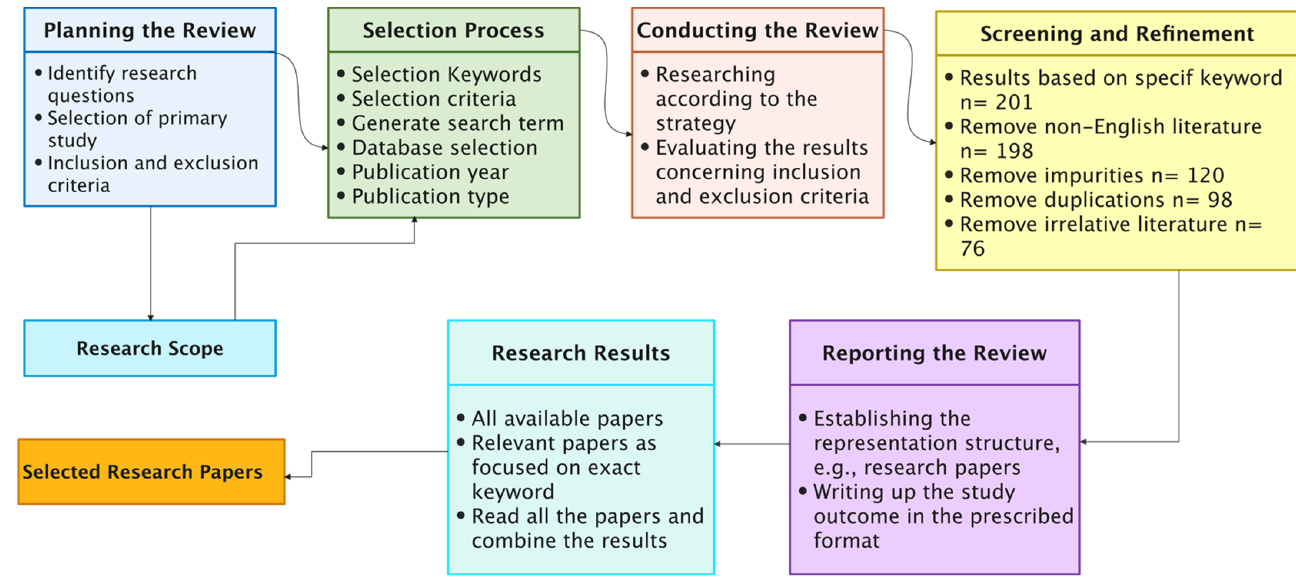
Figure 6. The process used to identify, gather, and refine research articles .